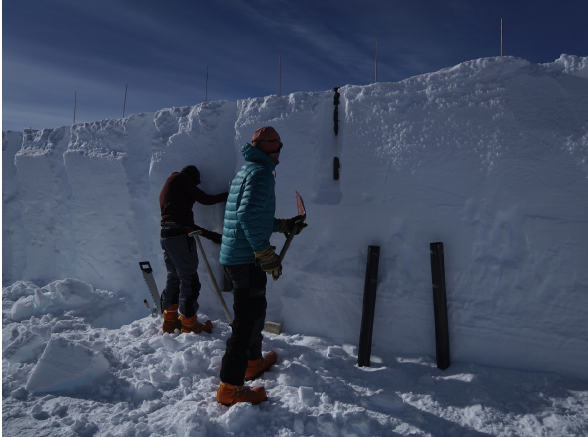
Figure 3. Sampling procedure in the OIR trench. The first carbon fiber tube (liner) is pushed into the snow after excavation of the trench. The positions were marked with a small bamboo pole. After retrieval of the first profile, the vertically consecutive second and third liners were taken. Two empty liners lean at the trench wall. The last liner had to be dug out partly as the trench was only 2 to 2.5m